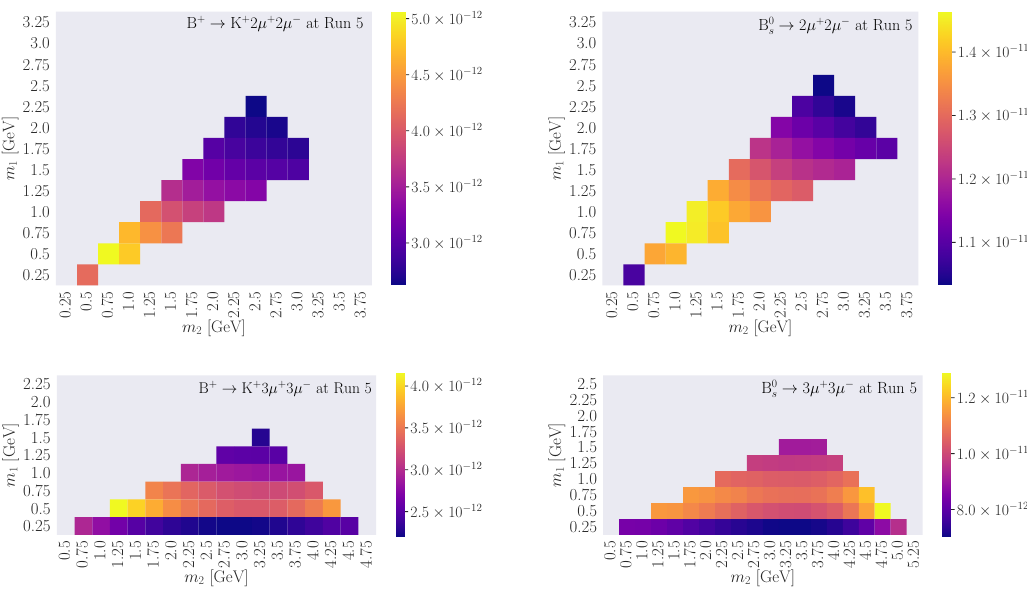
Figure 9 . Mass-dependent expected limits at Run 5 on the branching fractions of (top left) B + → K + 2 µ + 2 µ − , (top right) B 0 → 2 µ + 2 µ − , (bottom left) B + → K + 3 µ + 3 µ − and (bottom right) s B 0 → 3 µ + 3 µ − for a lifetime of the long-lived scalar of 1 ps . The top figures require that m 2 ≤ 2 m 1 . s The decays are reconstructed inclusively by requiring four muons as Long tracks.